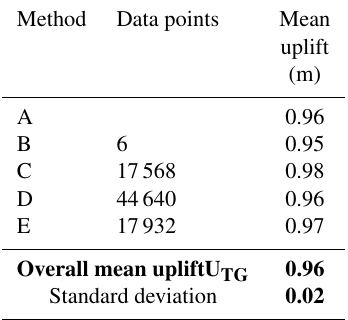
Table 2. Absolute uplift values calculated from the Kaik¯oura tide- gauge data using methods B–E. Method B: comparison of average high-tide and low-tide readings from several tidal cycles (3d period) before and after the earthquake. Method C: aligning pre-earthquake tidal data with post-earthquake data and incrementally adjusting them until a best fit. Method D: comparing the average water eleva- tion from a pre-earthquake month to the same month’s data after the earthquake (December 2015 against December 2016). Method E: calculating the difference in average waterline elevations for an ex- tended period (44d) before and after the earthquake (14 November to 27 December). For Method A, we refer to the methodology estab- lished in Sect. 3.1 and presented in Table 1. The overall mean uplift, UTG and standard deviation are shown in bold and are calculated by summing mean uplift values from each method and dividing by the number of methods. Method Data points